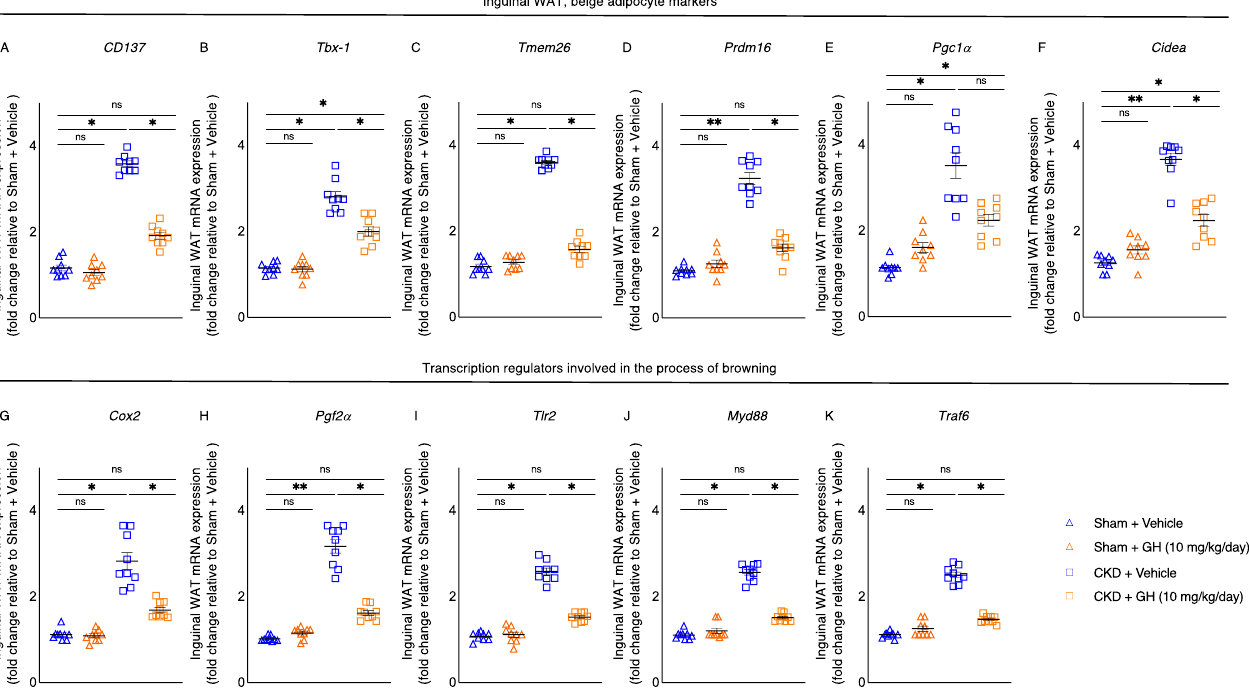
Figure 4 . GH reduces browning of adipose tissue in CKD mice. CKD mice were fed ad libitum, whereas other mouse groups received an energy intake amount equal to that of CKD + Vehicle